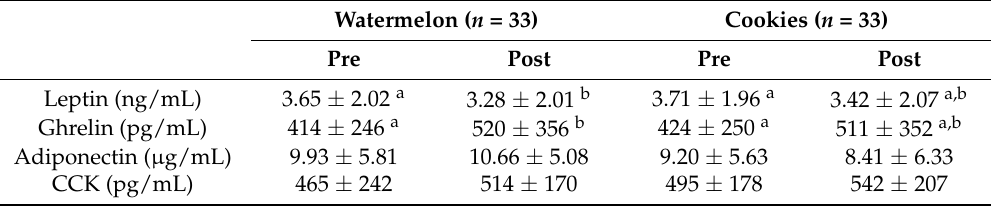
Table 2. Effects of WM or LFC consumption on postprandial satiety hormone.